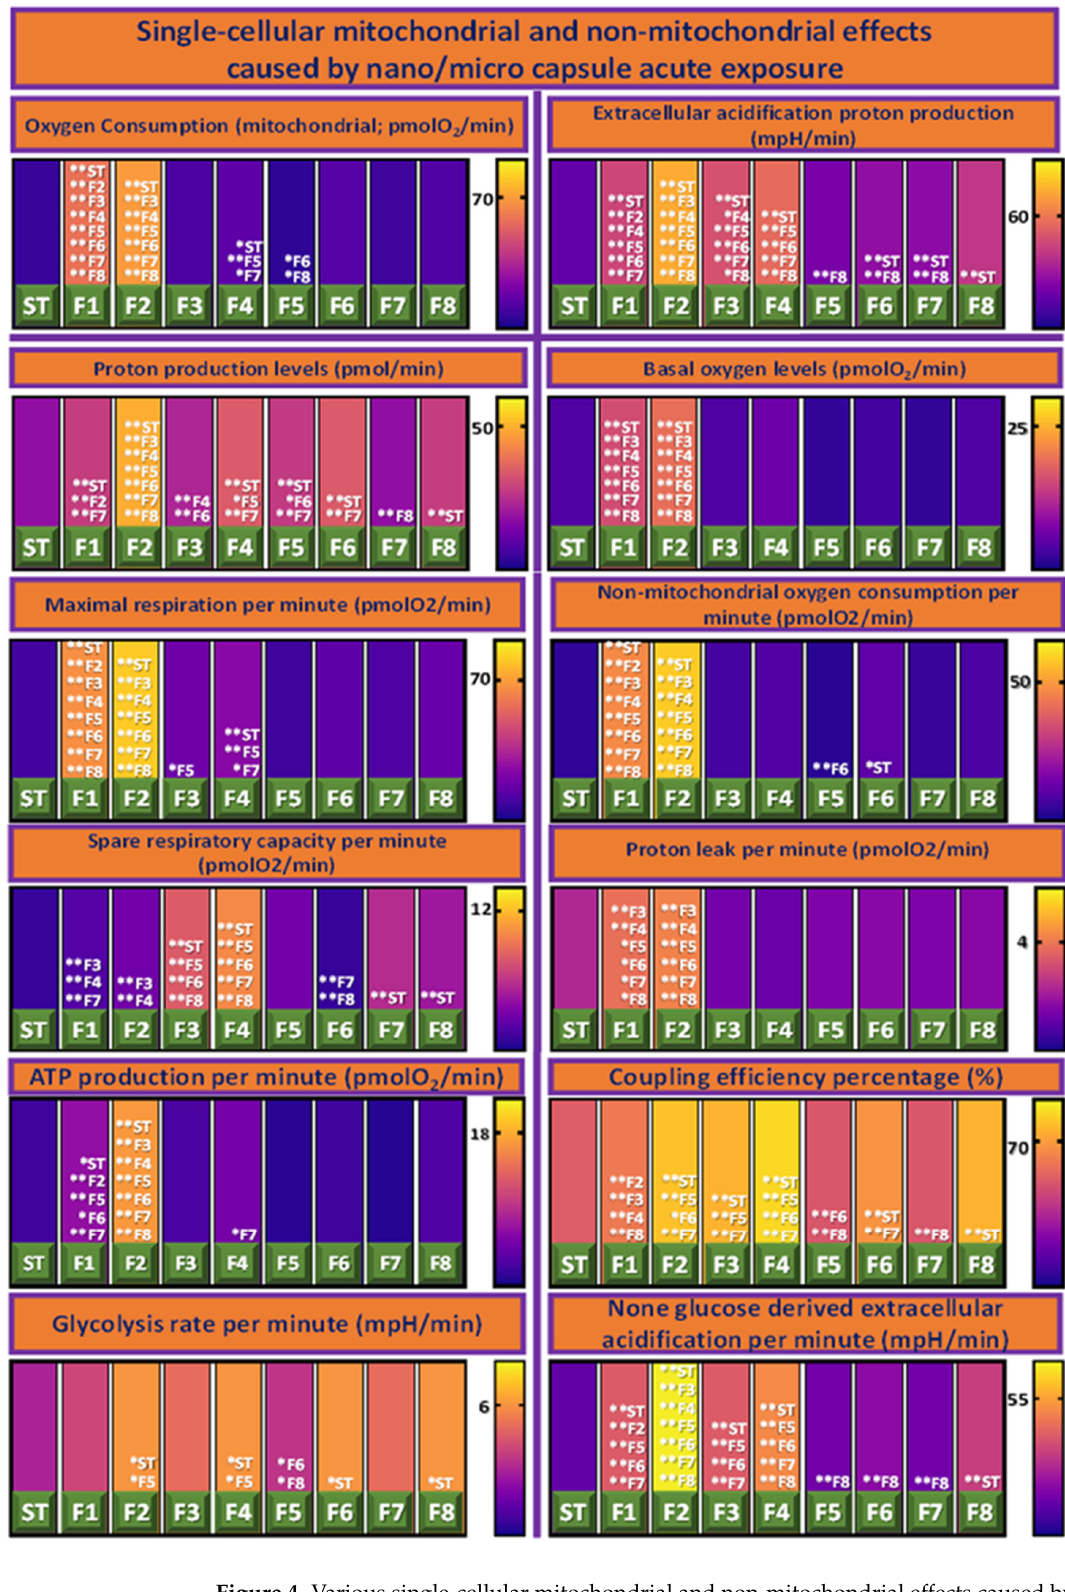
Figure 4. Various single-cellular mitochondrial and non-mitochondrial effects caused by micro/nano capsule acute exposure. Data are mean ± standard error of the mean, n = 3. Singular asterisk denotes where p < 0.05, whereas double asterisk denotes p <